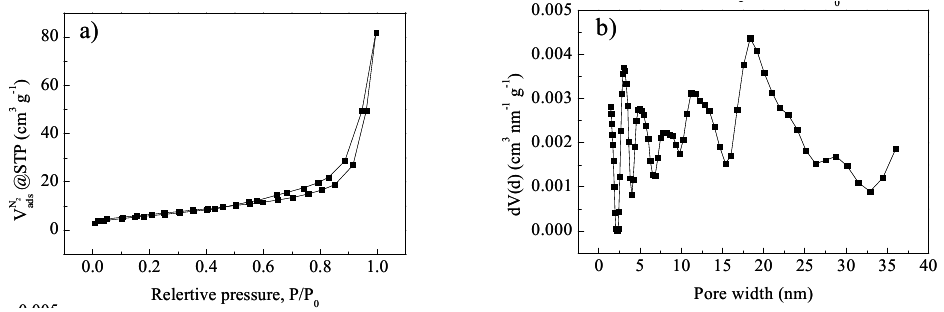
adsorption data at 77.4 K. ( a ) N Figure 4. N 2 distribution of LFP250-1-700.